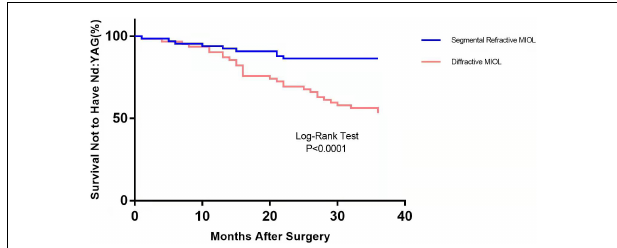
FIGURE 2 | Kaplan–Meier survival plots for eyes by different IOL types in different surgical treatments (Nd:YAG, neodymium:YAG laser capsulotomy; ACP, anterior capsule polishing).